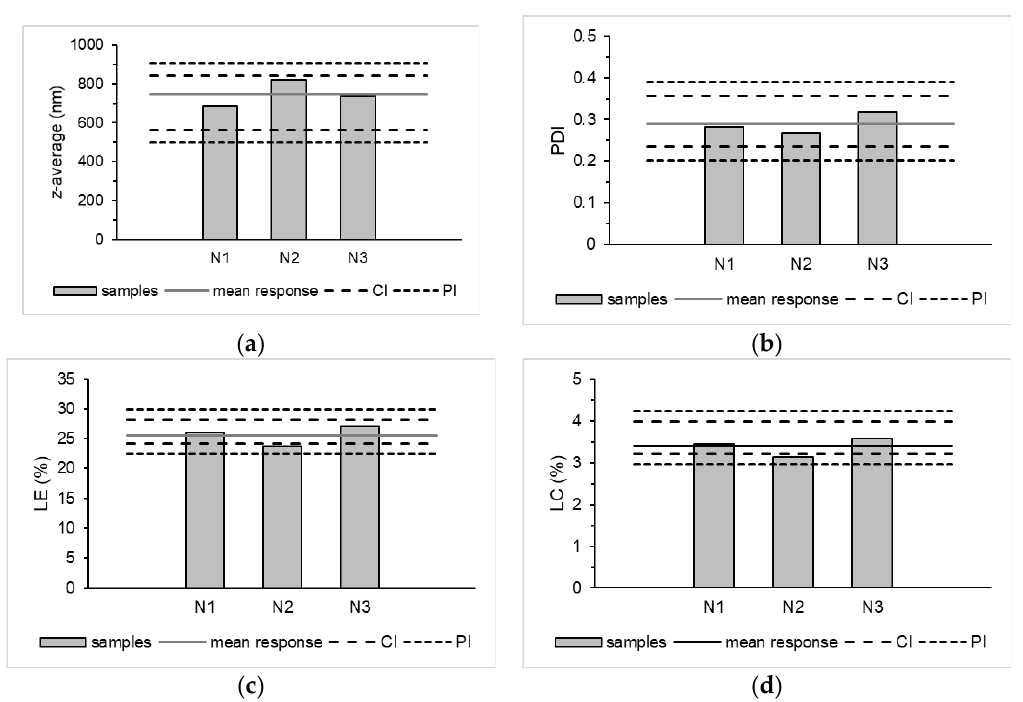
Figure 5. Verification of z-average ( a ), PDI ( b ), LE ( c ) and LC ( d ) of the product in triplicate and the 95 % confidence interval (CI) and 95 % prediction interval (PI).